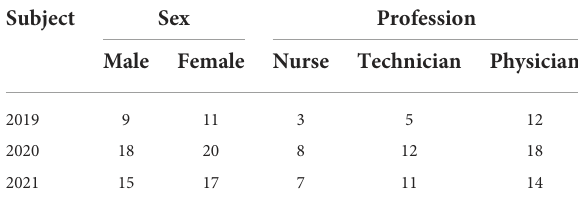
TABLE 1 Information on radiological staff working on iodine therapy in the nuclear medicine